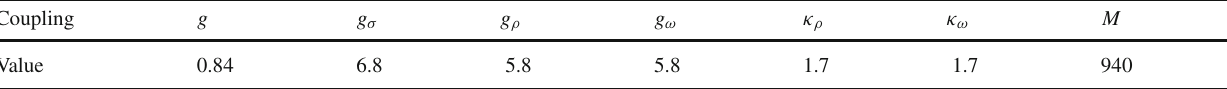
Table 1 Couplings of charmed baryons to light mesons. The magnetic coupling of the ρ and ω mesons are defined as f v = κ v g v , and M refers to the mass scale (in units of MeV) involved in the magnetic-type couplings Coupling g g σ g ρ g ω κ ρ κ ω M Value 0.84 6.8